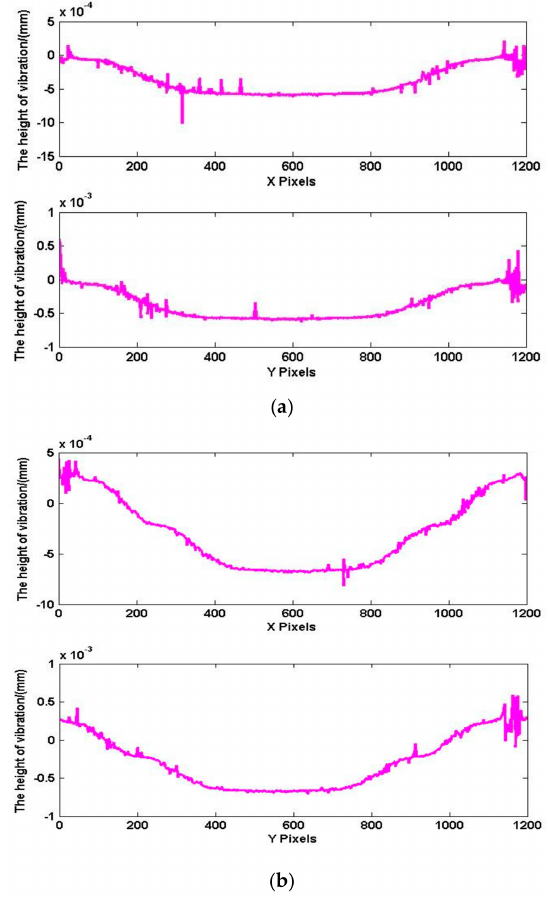
Figure 18. Data comparison at t 3 and t 4 moment. ( a ) The surface topography at t 3 moment; ( b ) maximum surface topography at t 4